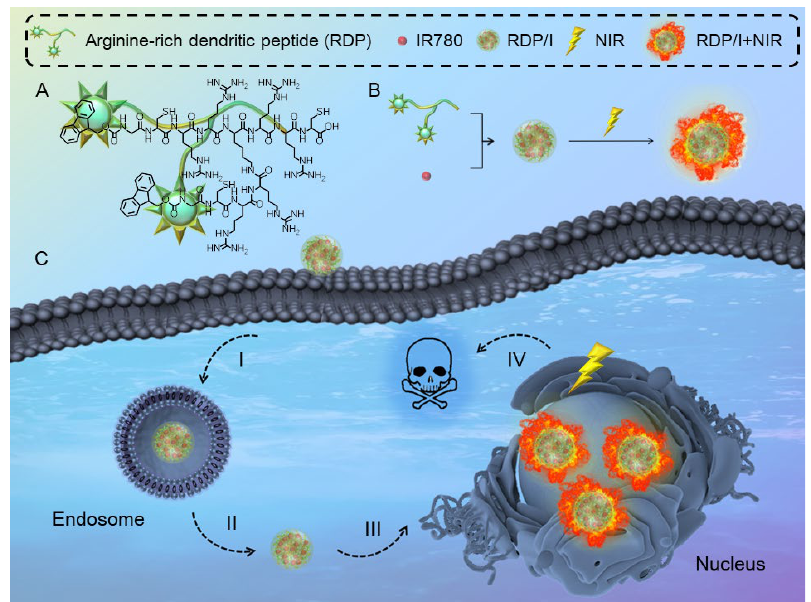
Figure 1. Structural formula of RDP ( A ); The synthesis diagram of RDP/I ( B ); Schematic diagram of the nanoheater RDP/I for precise nucleus-targeting photothermal therapy ( C ). (I) Nanoheater RDP/I was internalized in cells. (II) RDP/I escaped from the endosome. (III) RDP/I was anchored to the nucleus. (IV) Cell death due to the precise nuclear photothermal effect of RDP/I.